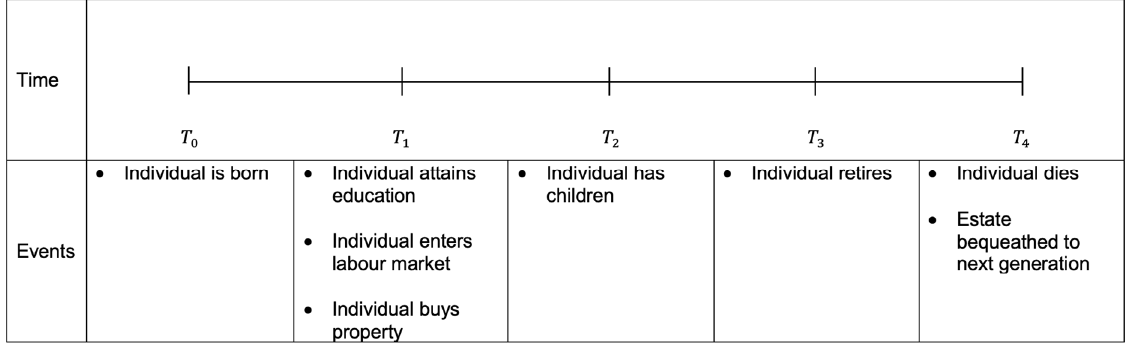
Figure 1. Life cycle model and events during the individual’s life cycle.